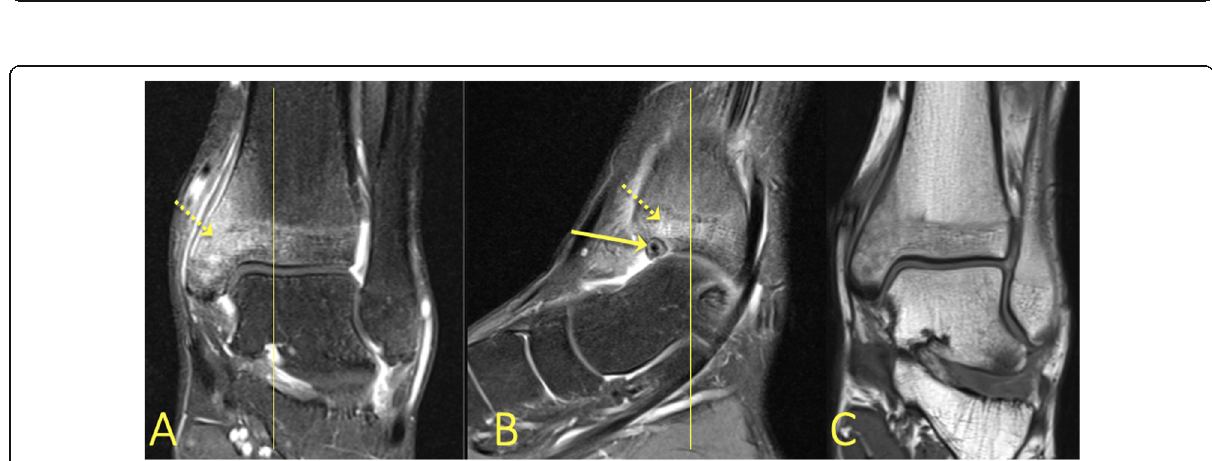
Fig. 30 A 28-year-old male presented with 3-month history of ankle pain and a suspected osteochondral lesion. MRI showed a solid lesion in the talar head and neck (arrow) with BME as a perilesional reaction (dashed arrow). Histological diagnosis was giant cell tumor